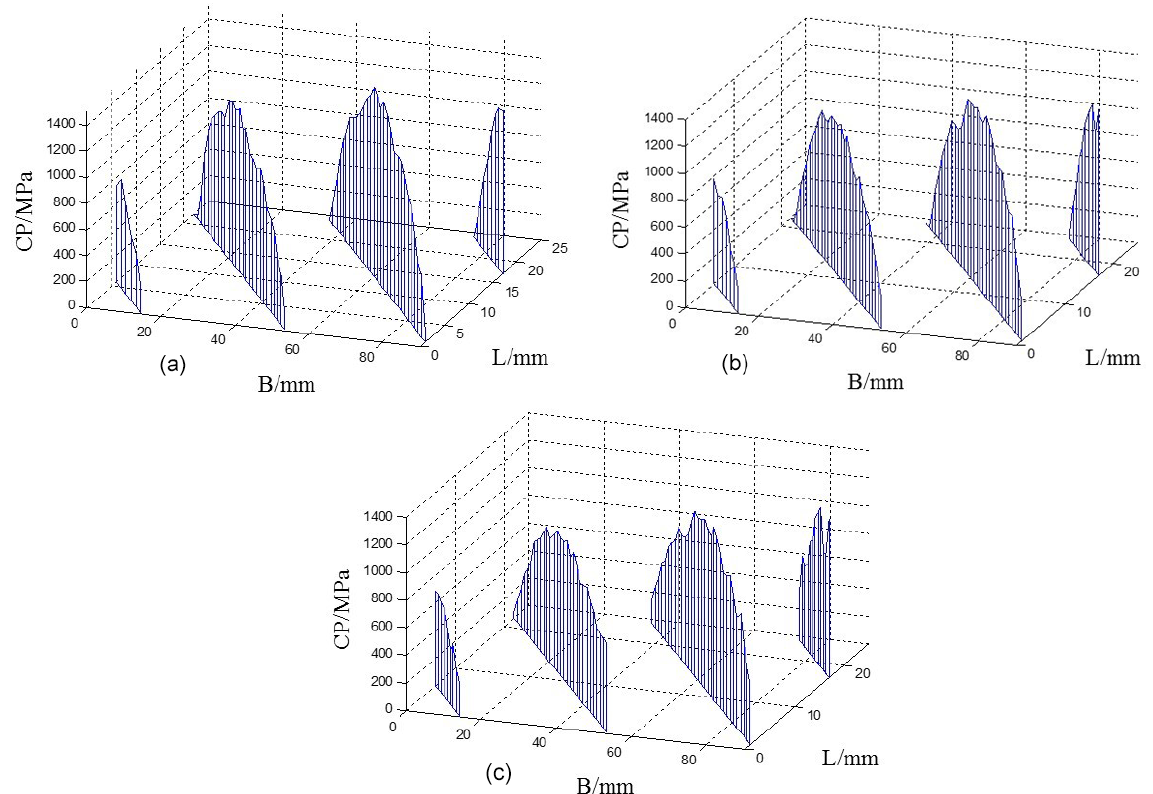
Figure 26. Contact stress distribution of the right tooth surface with the three different modification of the no. 4 shaft section stiffness. (a) Maximum amount of modification at 37µm. (b) Maximum amount of modification at 28.5µm. (c) Maximum amount of modification at